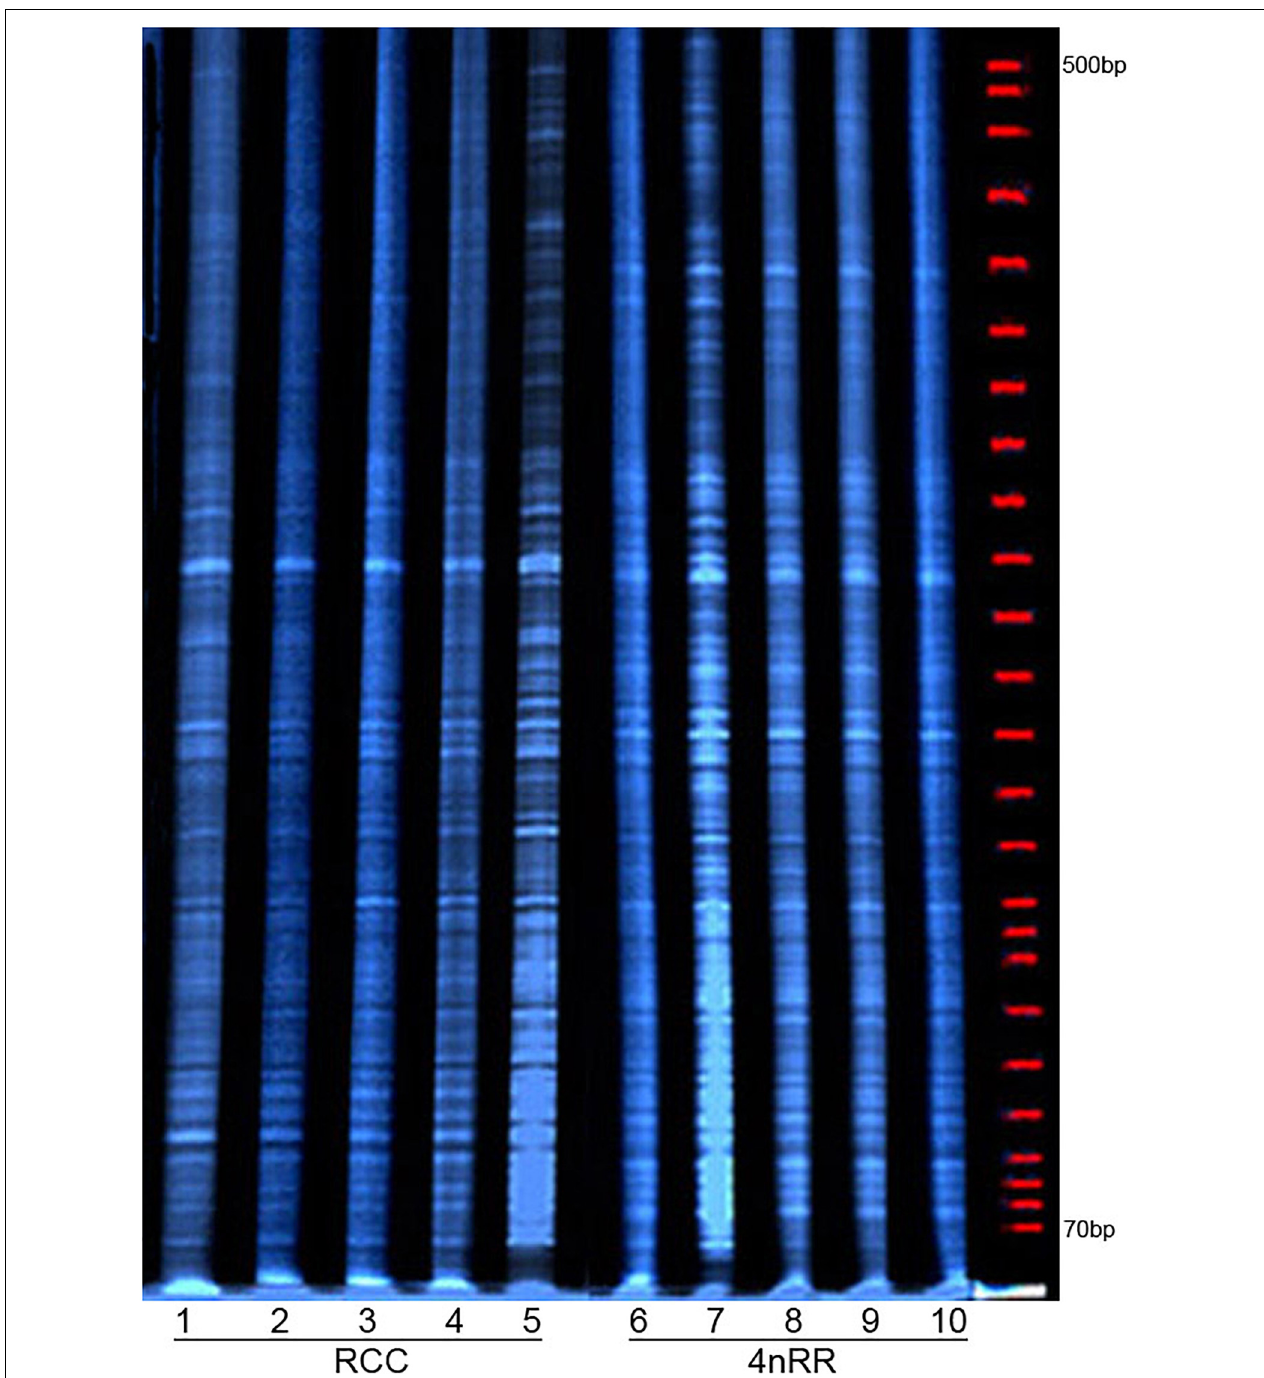
FIGURE 4 | Examples of an AFLP analysis. Numbers 1–5, and 6–10 represent the different individuals of Carassius auratus red var. (RCC), and autotetraploid Carassius auratus (4nRR), respectively.